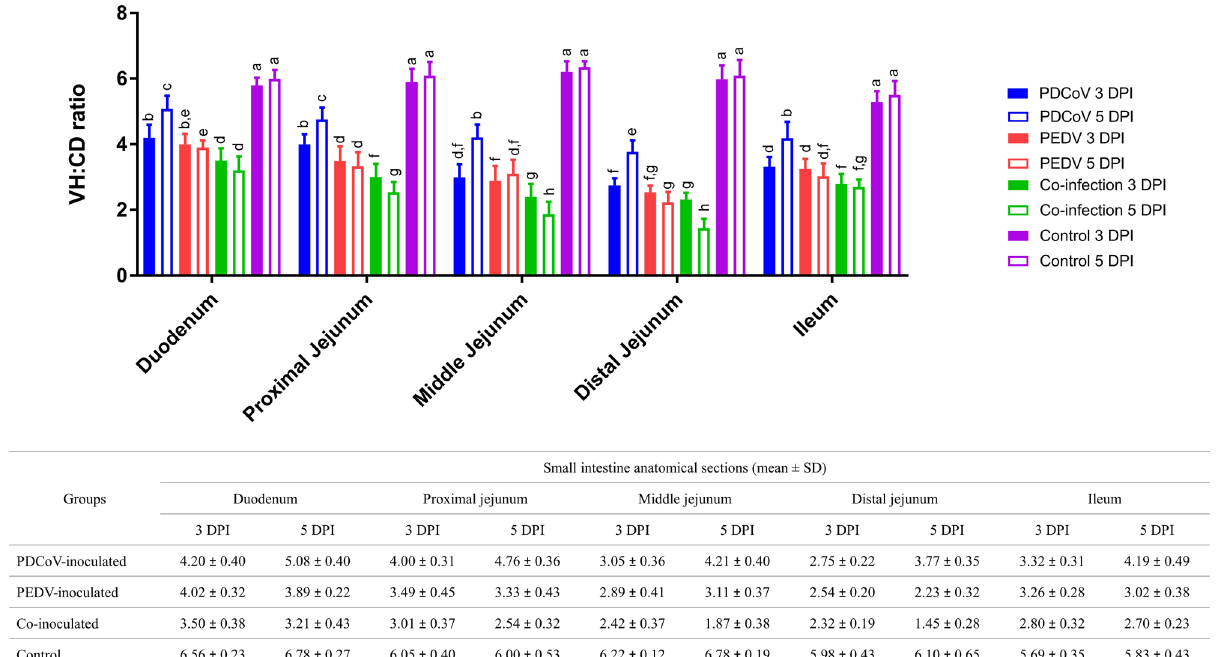
Figure 3. Villous height and crypt depth (VH:CD) ratio in the duodenum, proximal jejunum, middle jejunum, distal jejunum, and ileum. Blue, red, green, and purple bars represent PDCoV-inoculated, PEDV-inoculated, co-inoculated, and control groups. Solid and open bars represent 3- and 5-days post-inoculation (dpi), respectively. Different lower-case letters indicate significant differences between each group, each dpi, and each anatomical section of the small intestine ( p < 0.05). Values of mean ± standard deviation (SD) of each group, and each dpi are presented in a table under the